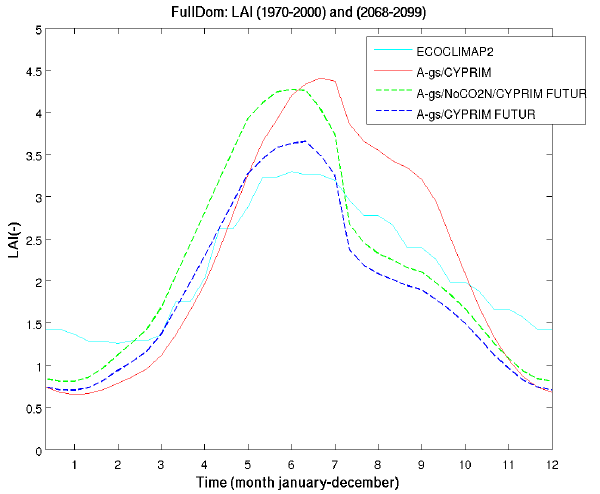
Figure2: Mean annual cycle of LAI for the full domain (FullDom), averaged over 1970-2000 3 Fig. 2. Mean annual cycle of LAI for the full domain (FullDom), for the ECOCLIMAP2 database, and for ISBA-A-gs with the CYPRIM forcing (A-4 averaged over 1970–2000 for the ECOCLIMAP2 database, and for gs/CYPRIM), and averaged over 2069-2099 for ISBA-A-gs with the CYPRIM scenario (A-5 ISBA-A-gs with the CYPRIM forcing (A-gs/CYPRIM), and aver- gs/CYPRIM FUTUR), and for ISBA-A-gs/NoCO2N with the CYPRIM scenario (A-6 aged over 2069–2099 for ISBA-A-gs with the CYPRIM scenario gs/NoCO2N/CYPRIM FUTUR). 7 (A-gs/CYPRIM FUTUR), and for ISBA-A-gs/NoCO2N with the CYPRIM scenario (A-gs/NoCO2N/CYPRIM FUTUR).